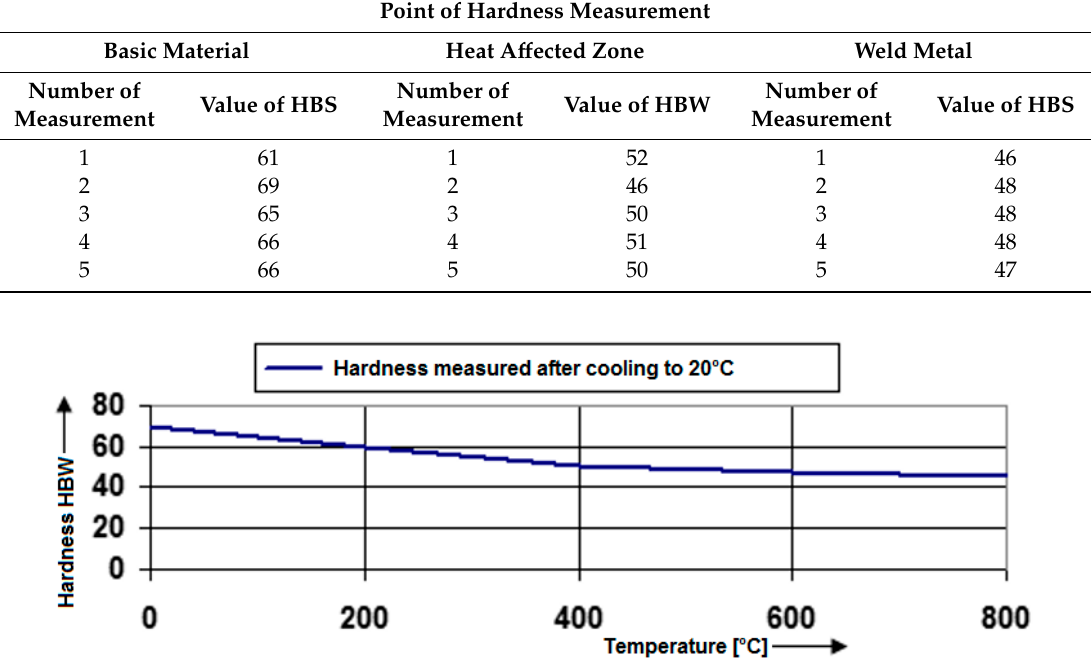
Figure 20. Hardness dependence of the material EN AW 6063.T66 based on the heating temperature during welding.